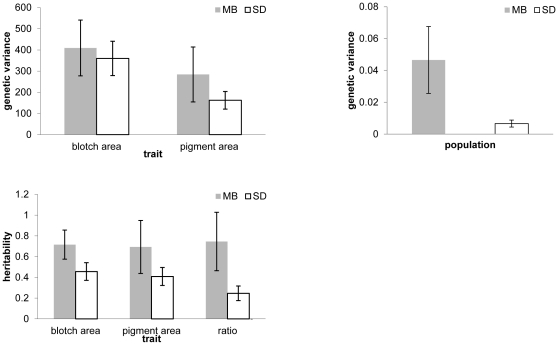
Genetic variances and heritabilities of color traits in the South Dakota and Manitoba populations of Thamnophis sirtalis.A. Genetic variances of blotch area and pigment area. B. Genetic variance of blotch area/pigment area ratio. C. Heritabilities of blotch area, pigment area, and blotch area/pigment area ratio. Error bars represent plus or minus one standard error of the variance as estimated by from 10,000 bootstrap replicates.